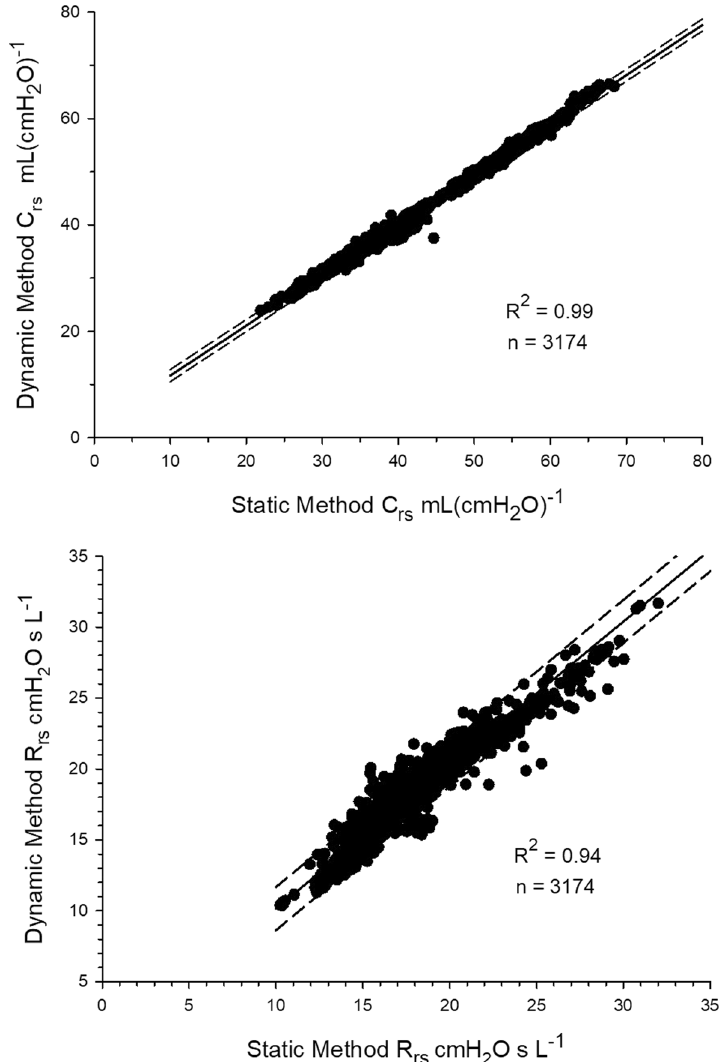
Fig. 3 Pearson’s linear regression using data generated by the 15 patients in the study. Compared were average epoch measurements of C rs and of R rs by the static and dynamic methods ( n (